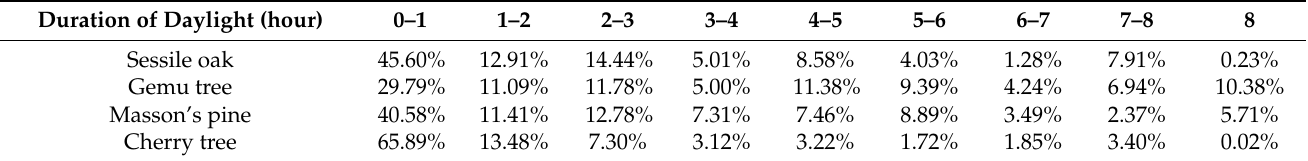
Table 4. Statistical table of daylight duration classified by hours for four species of trees in relative area of faces (triangles). Duration of Daylight